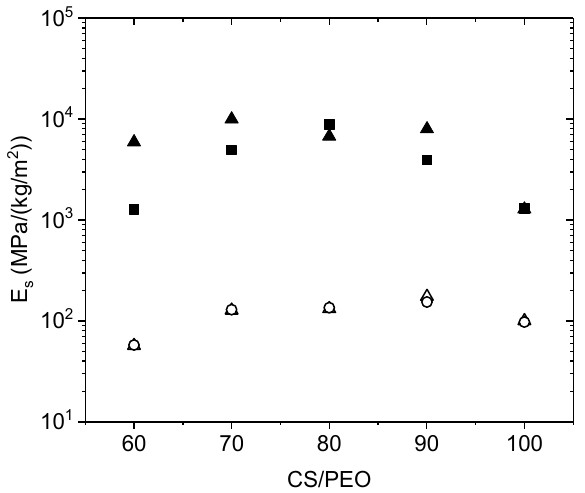
Figure 3. Specific modulus E s expressed in MPa/(kg/m 2 ) obtained by DMA on initial blended film for powdered PEO added in 5% chitosan solution (dried state ▲ , ■ ) and after PEO ( M W = 1 × 10 6 ) extraction, after drying and rehydration (wet state ∆ , ○ ). Standard deviation is lower than 10%. Table 2. Experimental values of E s obtained in DMA on initial blended films and after extraction of PEO with different MW and concentrations being added in powder or